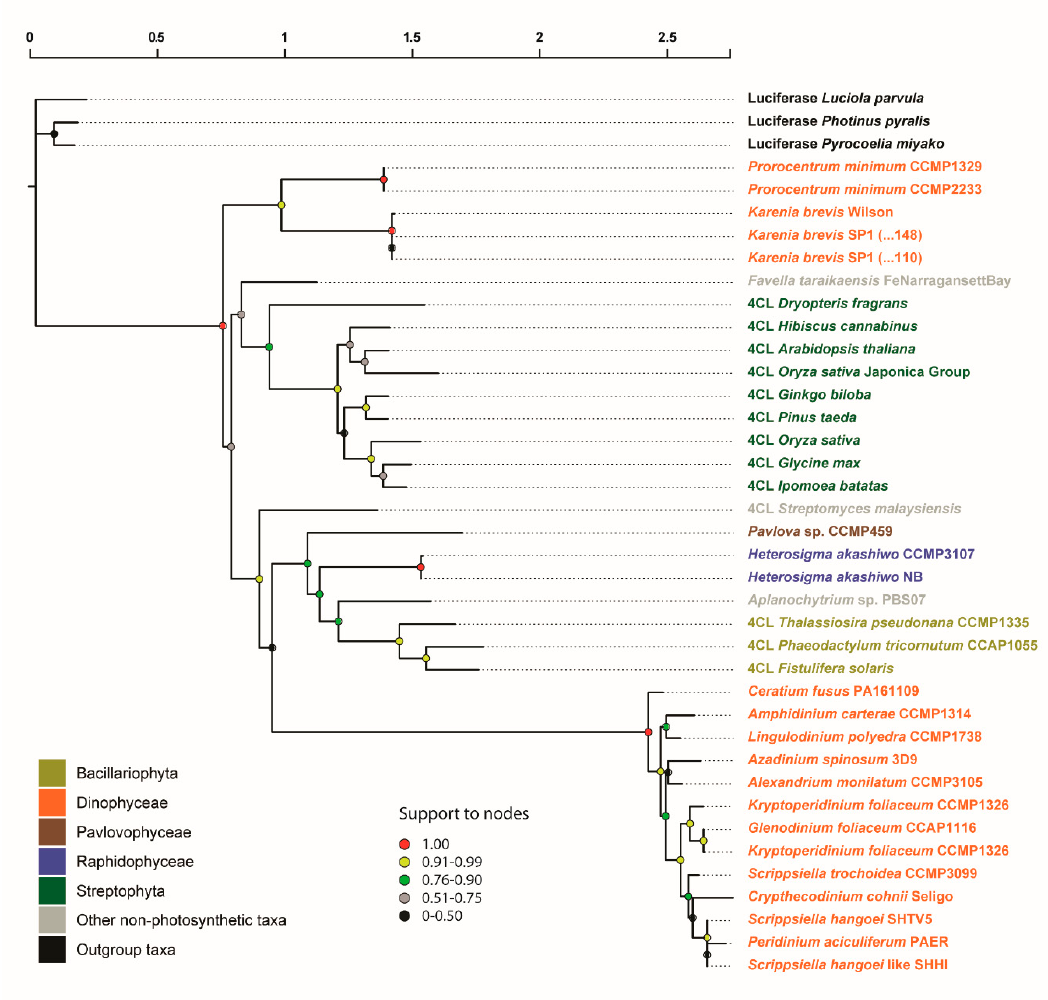
Figure 3. Maximum likelihood phylogenetic tree of 4-Coumarate:CoA ligase. Numbers in parentheses after strain denomination refer to the last three codes of transcripts. Support to nodes was inferred using the Shimodaira-Hasegawa-like test.